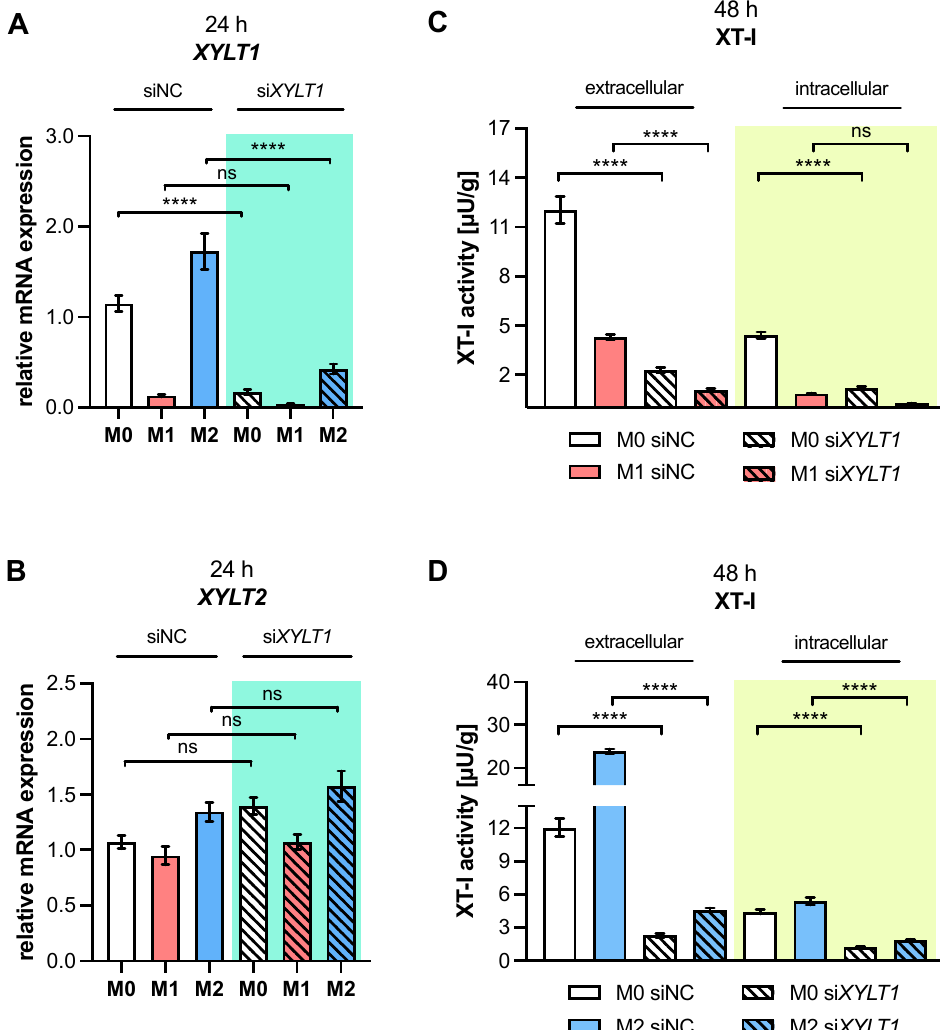
Figure 4. XYLT1 mRNA expression and cellular XT-I activity of polarized macrophages after siRNA-mediated XYLT1 knockdown. Negatively selected monocytes were differentiated into macrophages using M-CSF. On day 5, M Φ were treated with a non-targeting negative control siRNA (siNC) or an siRNA targeting XYLT1 (si XYLT1 ). On day 6, M Φ were stimulated with IFN- γ /LPS (M1), IL-4 (M2), or with no additive (M0). Cells were harvested for qRT-PCR analysis (n, sample = 3; n, biological = 2; n, technical = 3) after a polarization time of 24 h, in order to determine the relative gene expressions of ( A ) XYLT1 and ( B ) XYLT2 using the ΔΔ C T method. ( C ) M1 and ( D ) M2 M-M Φ were harvested 48 h post-transfection for cellular XT-I activity determination (n, sample = 3; n, biological = 3; n, technical = 3) of the XYLT1 knockdown cultures via mass spectrometry. The cell culture supernatant was used for extracellular XT-I activity, while the cell lysate was used for intracellular XT-I activity measurement. All data were analyzed using one-way ANOVA, followed by Tukey’s multiple comparison tests, and expressed as mean ± SEM. ns (not significant), p < 0.0001 (****). The transfection of M0 M-M Φ with an siRNA that targeted XYLT1 (si XYLT1 ) significantly reduced XYLT1 mRNA expression by 85.1% ( p < 0.0001) relative to M0 M- M Φ that was transfected with a non-targeting negative control siRNA (siNC). As M1 M- M Φ already possessed significantly diminished XYLT1 mRNA expression compared to